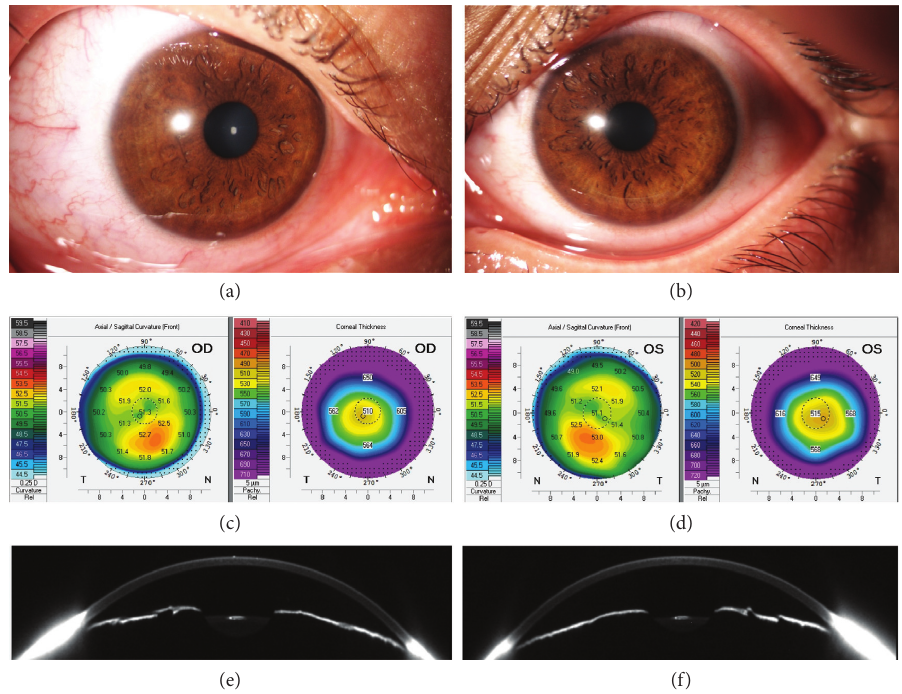
Figure 3: Anterior segment imaging in an individual with PRSS56- associated nanophthalmos. Slit-lamp photographs of the right (a) and left (b) eye appearing normal (age 16.5 years). Axial curvature and pachymetry maps of the right (c) and left (d) cornea (age 15 years) documenting high steepening and normal corneal thickness. Scheimpflug images of the horizontal cross sections of the right (e) and left (f) anterior segment showing narrow iridocorneal